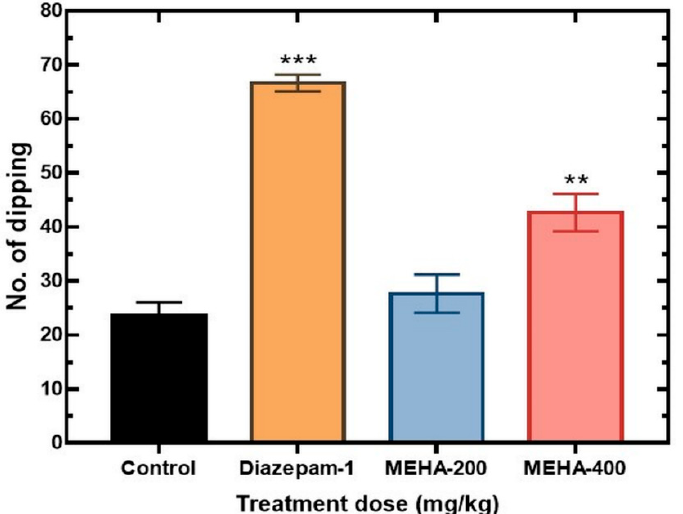
Figure 4. Anxiolytic activity of MEHA on hole board test in mice. Results are expressed in mean ± SEM. ** p < 0.01 and *** p < 0.001, significantly different from control; ANOVA followed by Dunnett’s test ( n = 3, per group). MEHA: methanol extract of Homalomena aromatica leaves (200 mg/kg and 400 mg/kg); Reference drug diazepam 1 mg/kg.